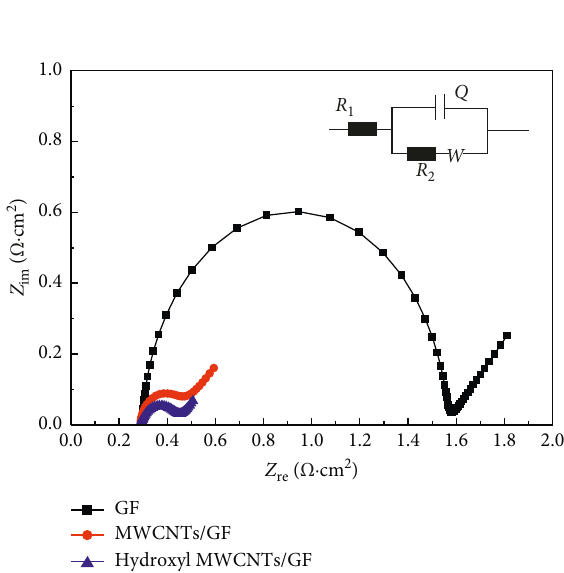
Figure 6: EIS spectra of cells with different electrodes and fitted equivalent circuit. Table 4: Fitted parameters resulting from the equivalent circuit